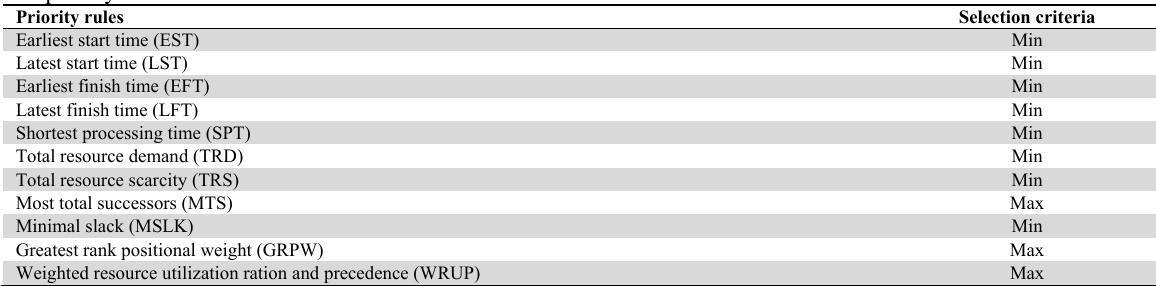
The priority rules and the selection